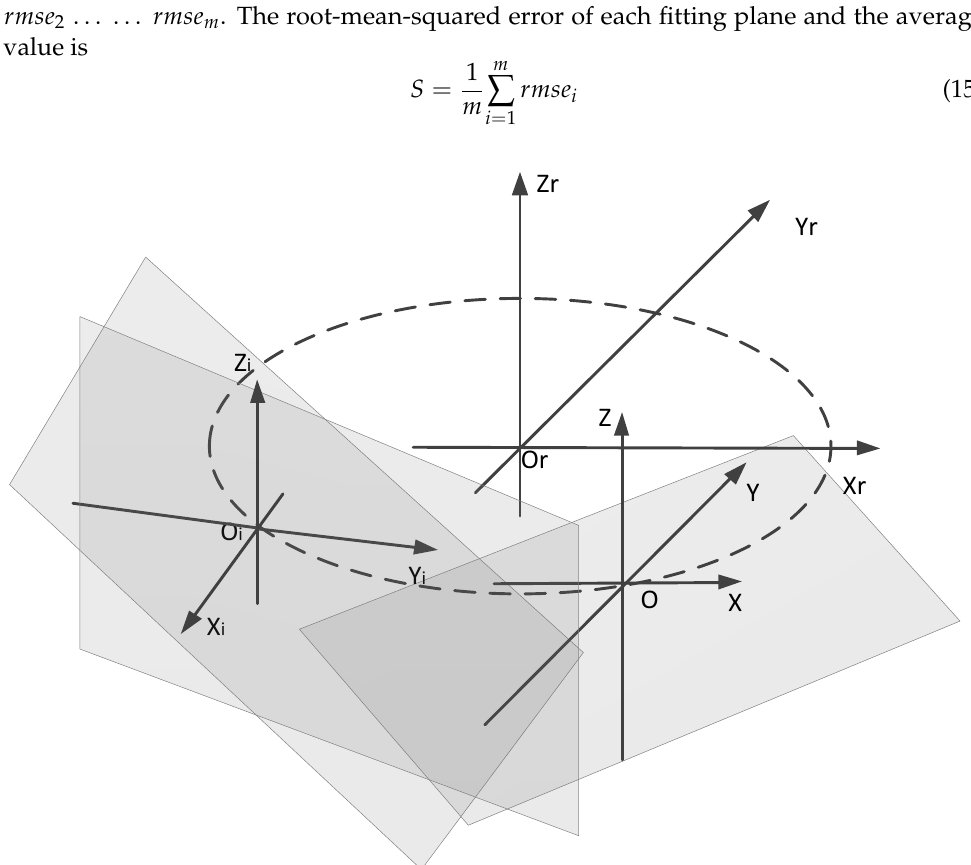
Figure 4. Schematic of different plane positions. Take Equation (15) as the objective function and search for the best value of M and N in the interval of a ≤ M ≤ b, c ≤ N ≤ d with a certain step length. Minimize the value of S, and use this optimized value of M and N as the result of positional parameter calibration. The Algorithm 1 is as the